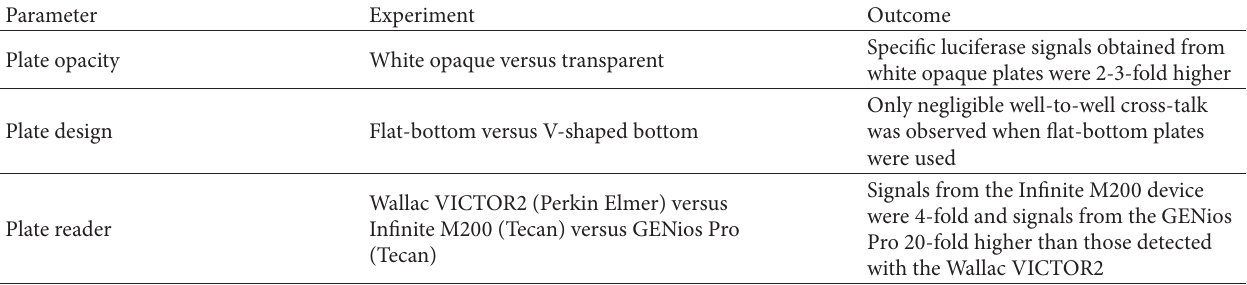
Specific luciferase signals obtained from white opaque plates were 2-3-fold higher Only negligible well-to-well cross-talk was observed when flat-bottom plates were used Signals from the Infinite M200 device were 4-fold and signals from the GENios Pro 20-fold higher than those detected with the Wallac